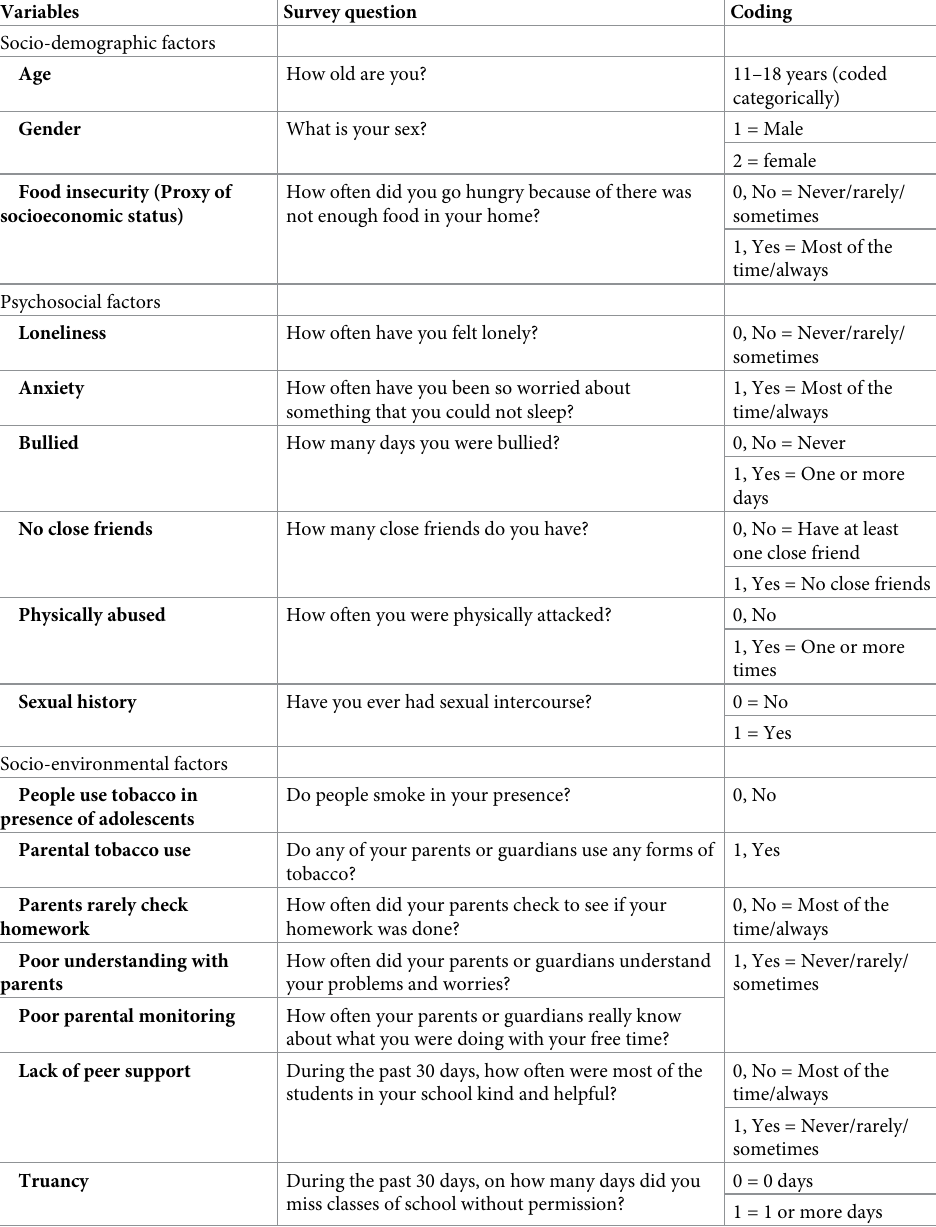
Table 1. The complete list of independent